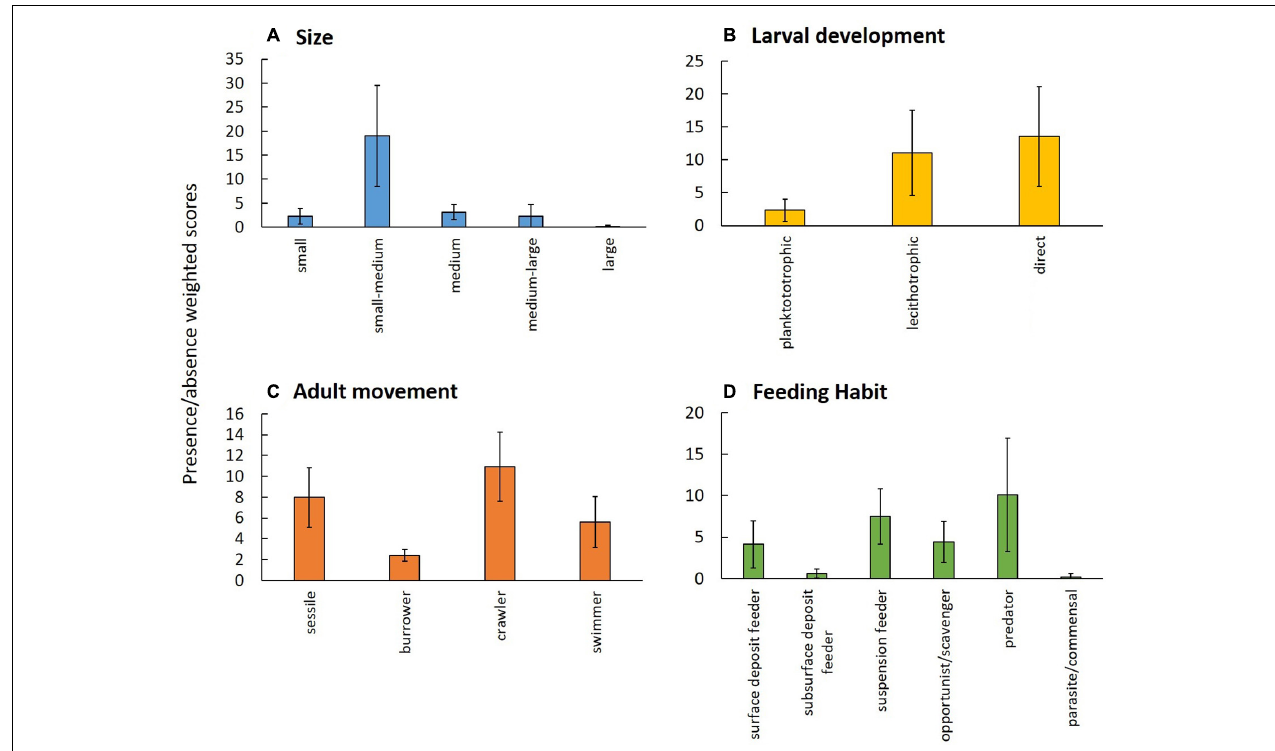
FIGURE 2 | Occurrence of trait modalities based on presence/absence of taxa for combined ROV and trawl data of epibenthos from the Chukchi Borderland and averaged across all stations ± SD; (A) body size, (B) larval development, (C) adult movement, and (D) feeding habit; note that y -axes have different scales. Trait modalities are defined in Table 2